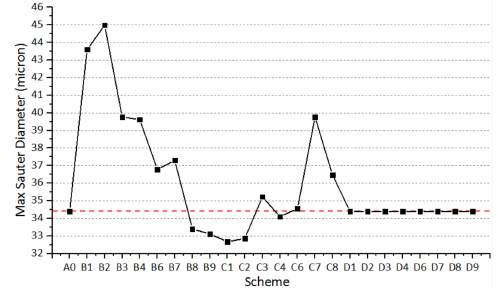
Figure 39. Max SMD for each optimized case.